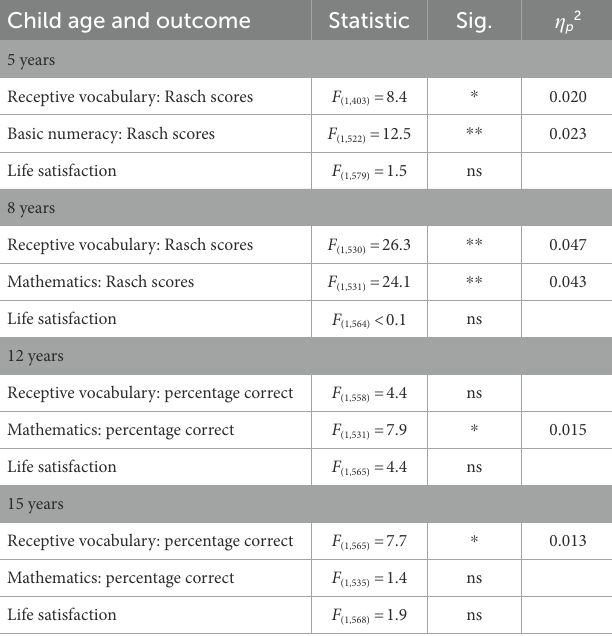
TABLE 10 Summary of analyses comparing outcomes between rural Vietnamese children who received a low dose of preschool education ( n = 426) and those who did not attend preschool ( n =